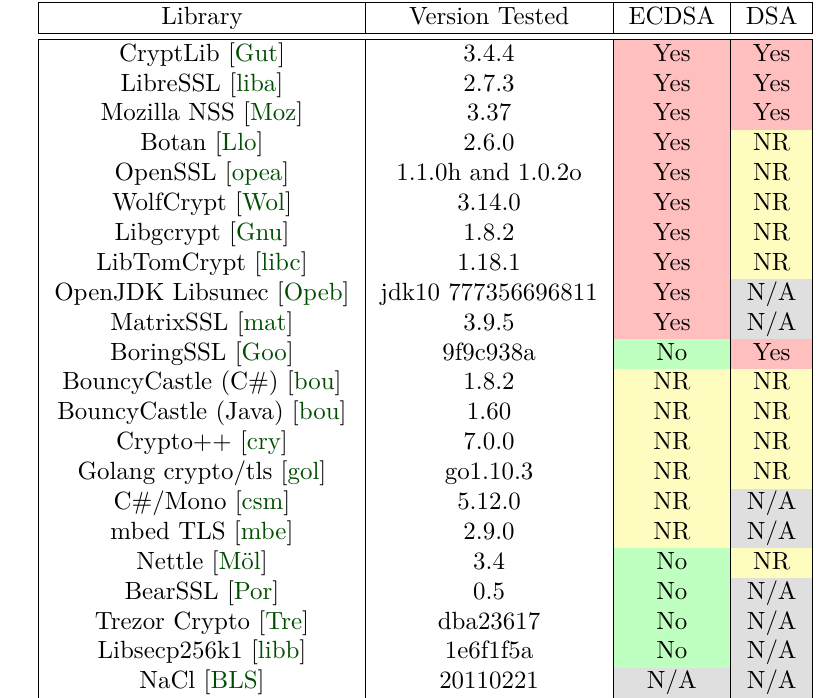
Table 1: Cryptographic implementations of (EC)DSA signatures. The table examines several popular cryptographic libraries to see if they follow the vulnerable pattern. If modular reduction both precedes and follows the addition of m and the modular reduction routine is not constant time, the entry is marked as a “Yes.” If the product rx or the sum m + rx is not reduced, then the entry is marked as “NR” because it is not vulnerable to this attack, but information may still be leaking during arithmetic operations involving x